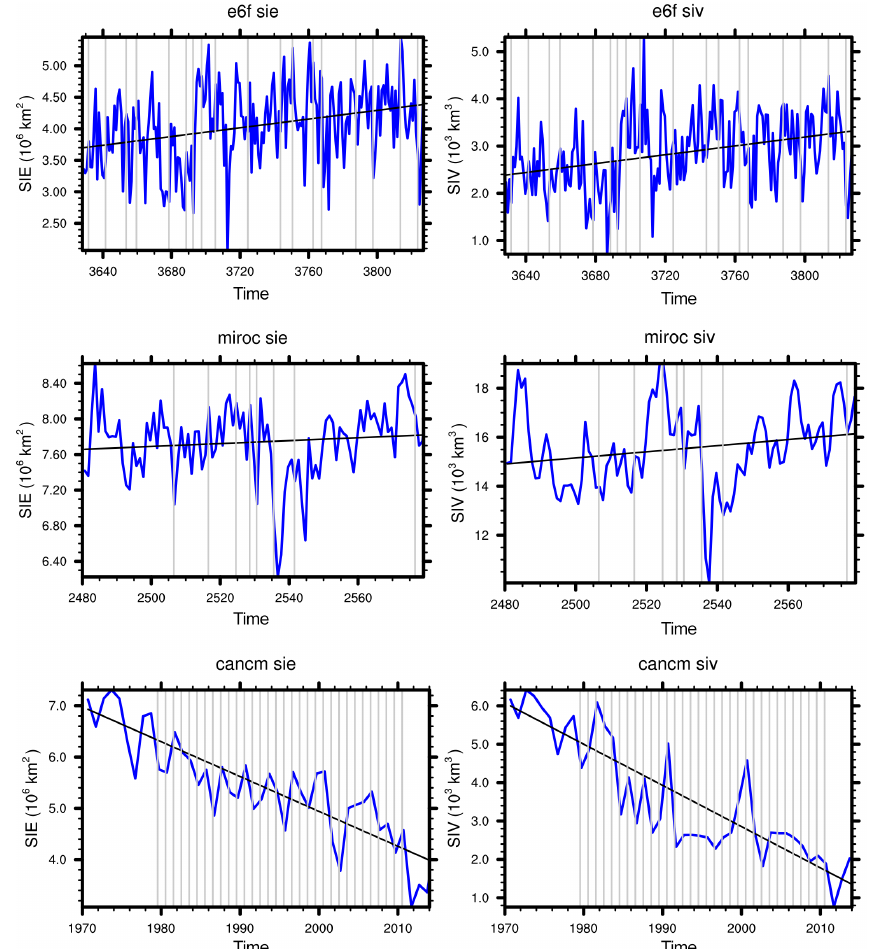
Figure 1. Time series of monthly mean September sea ice extent (sie, left column) and sea ice volume (siv, right column) in each model’s control simulation (blue) with the line of best fit to data (black). Vertical grey lines indicate start years used to initialise simulations. Values on the time axis are model clock times, and do not correspond to the actual run length of the